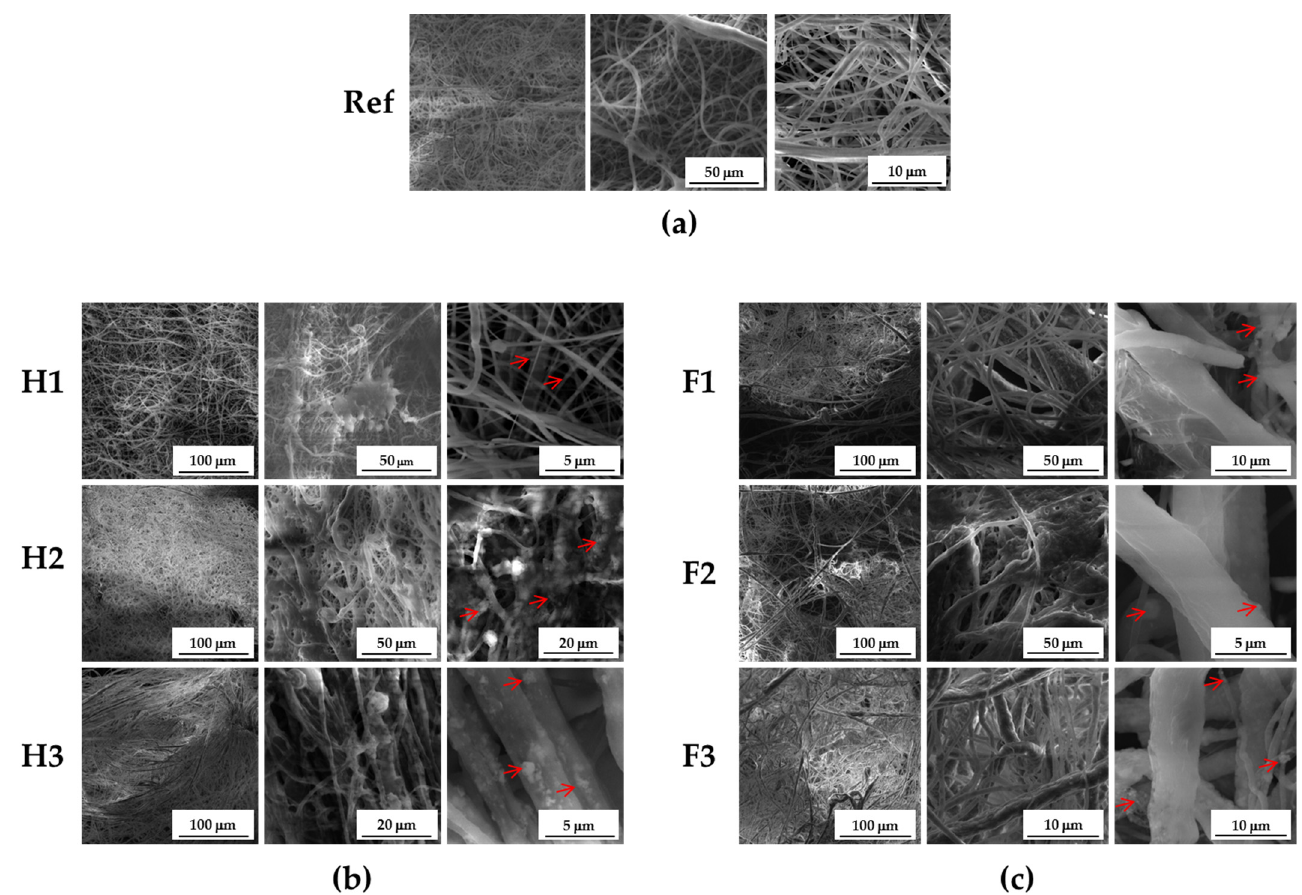
Figure 1. SEM images of electrospun nanofibers: ( a ) pure PCL and its blends containing ( b ) 1% (H1), 3% (H2) and 7% (H3) HAp or ( c ) 1% (F1), 3% (F2) and 7% (F3) FAp, respectively. Representative images are shown at different magnification. Red arrows indicate the aggregates of nanophased HAp or FAp deposited onto the nanofiber surface.